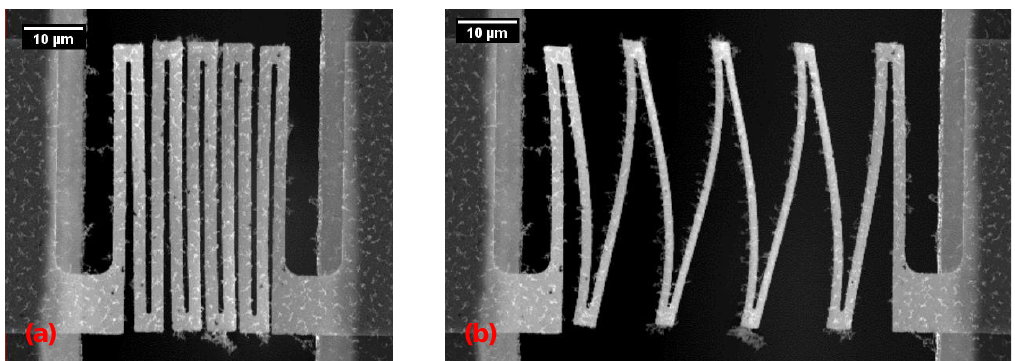
Figure 9. Two in situ SEM images showing the same interconnect in ( a ) initial and ( b ) stretched condition. The images demonstrate that the test structures fabricated in the test device can be strained inside the SEM as